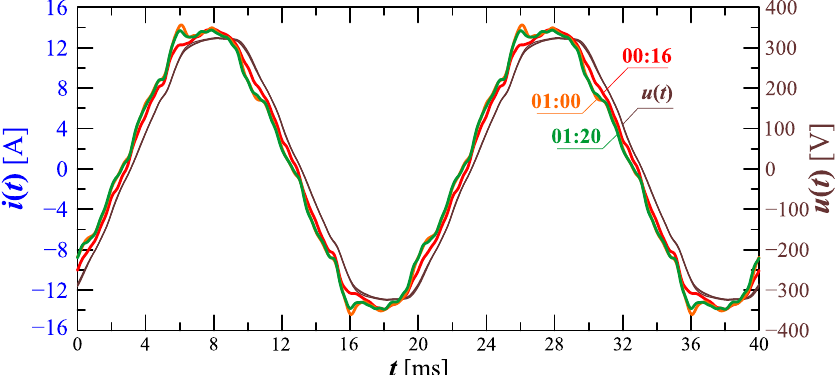
Figure 11. Recreated voltage waveforms u ( t ) and current waveforms i ( t ) recorded at 00:16, 1:00, and 1:20 for Case I.